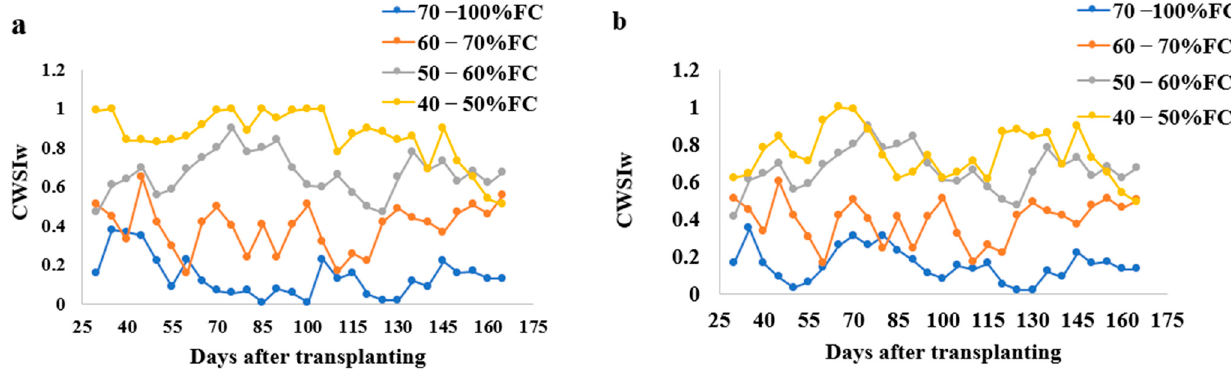
Figure 4. Variations of CWSI W with time during the growing season of tomatoes at different water stress levels in ( a ) sandy loam soil and ( b ) silt loam soil. Note: All the values used in the above figure are the mean values.